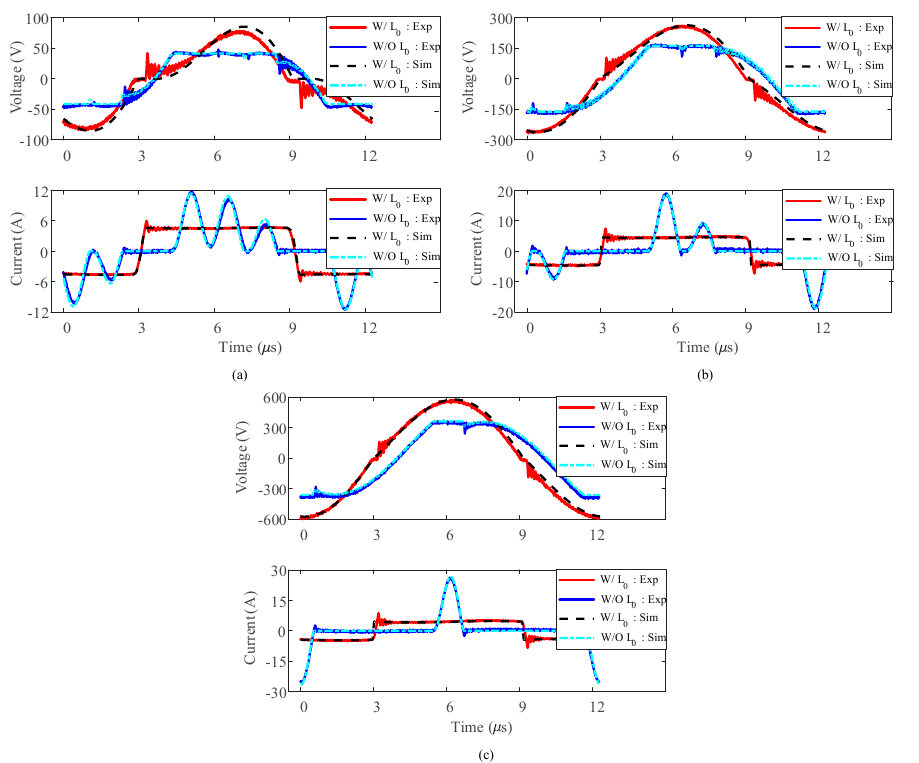
Figure 12. AC voltage and current waveforms of the rectifier ( a ) U bat = 40 V ( b ) U bat = 160 V ( c ) U bat = 360 V.